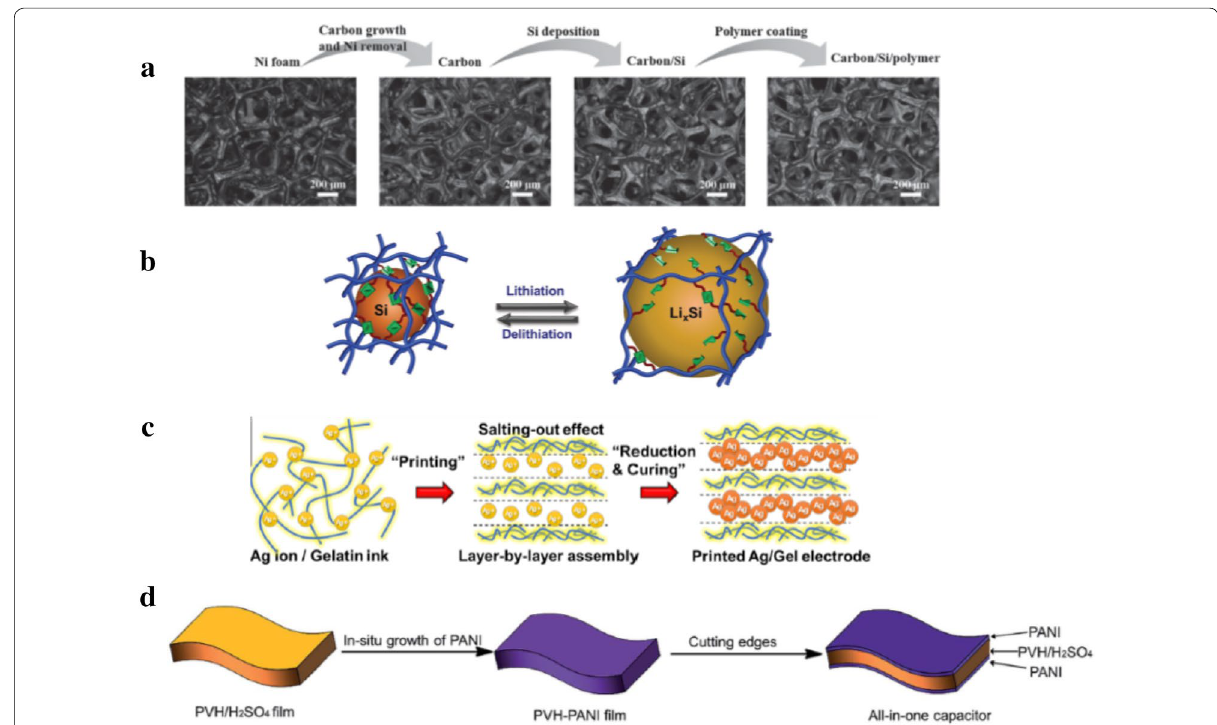
Fig. 7 Illustrations of healable conductive electrodes. a Synthesis and microscope images of carbon/Si/polymer electrode. Reproduced in part with permission [183], Copyright 2016, Wiley–VCH. b Schematic illustrating volume change during lithiation/delithiation. Reproduced in part with permission [184], Copyright 2018, Wiley–VCH. c Schematic of self-layering mechanism of Ag nanosheets Reproduced in part with permission [185], Copyright 2018, American Chemical Society. d Schematic of capacitor fabrication. Reproduced in part with permission [186], Copyright 2018, The Royal Society of